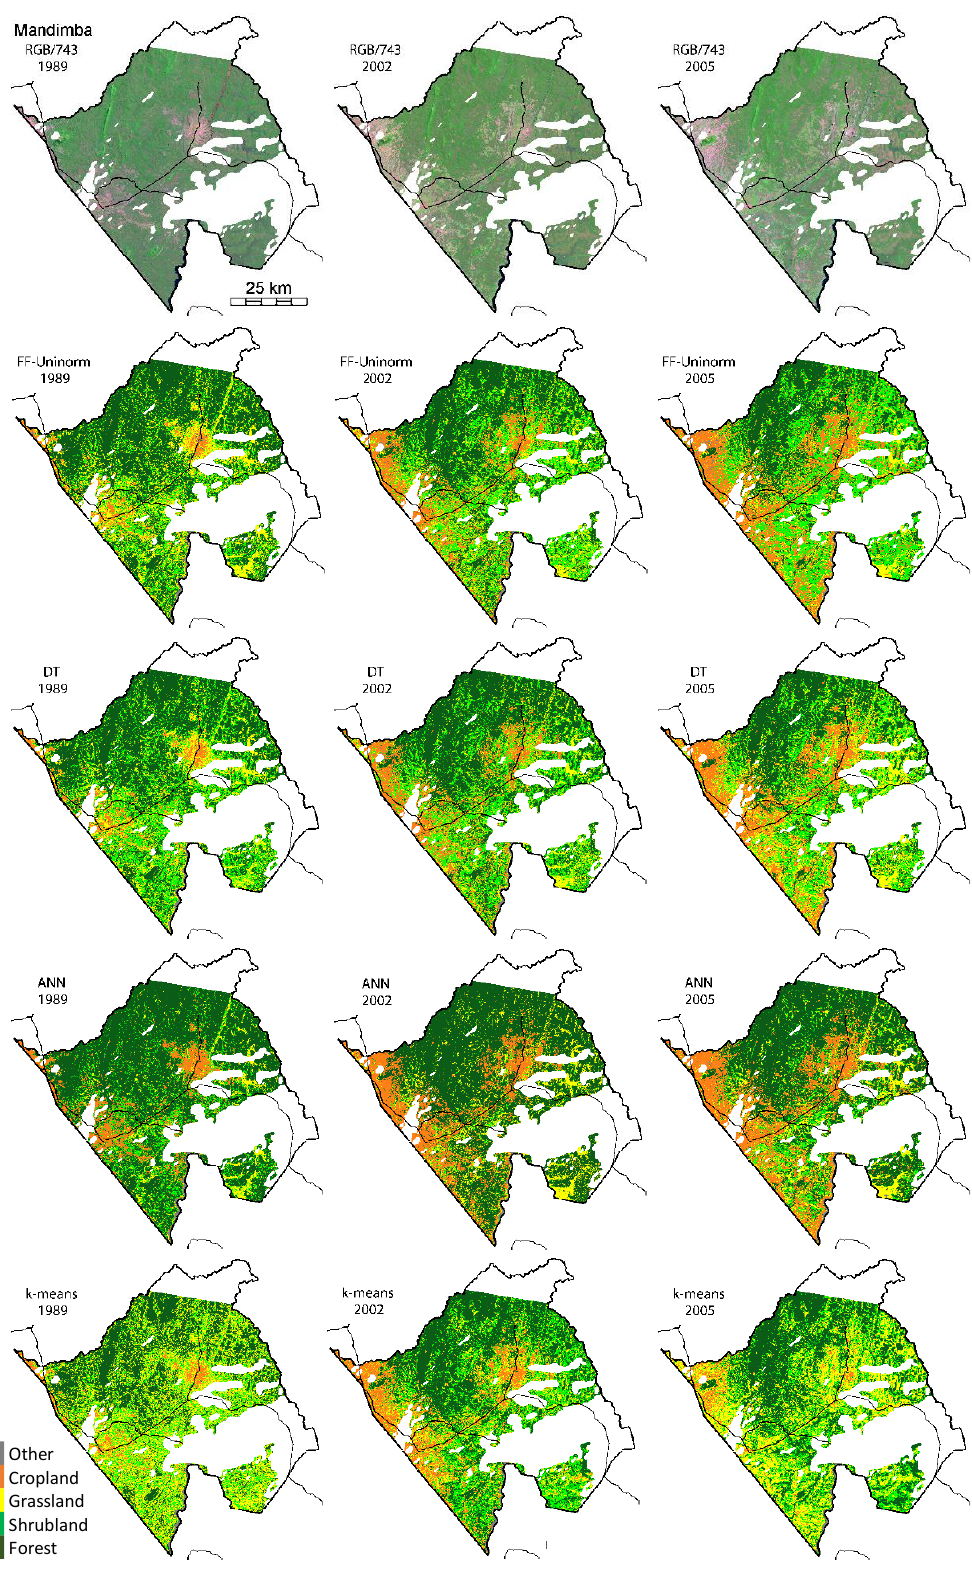
Figure 5. Land cover classification results using FF-Uninorm, decision trees, artificial neural networks and k-means clustering.